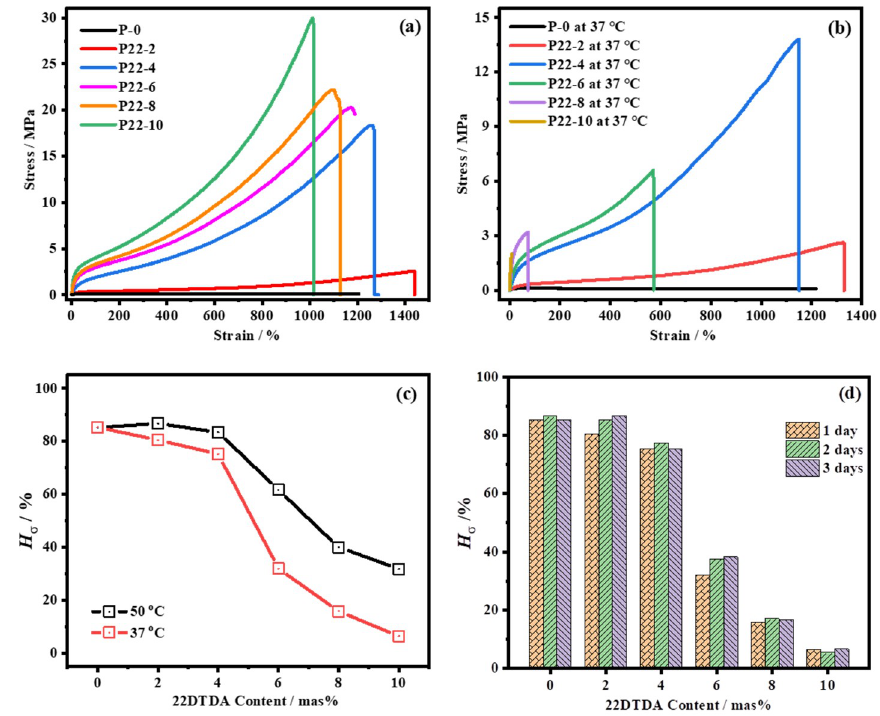
Figure 9. Typical tensile curves of the WPUR films with 22DTDA contents from 0 to 10 mas% before ( a ) and after ( b ) healing at 37 °C for 24 h; ( c ) plots of the recoveries of the ultimate tensile strength (H σ ) after heating at 50 and 37 °C for 24 h as a function of the 22DTDA content; ( d ) the bar graph of H σ with different 22DTDA contents after heating at 37 °C for 1 day, 2 days, and 3 days.